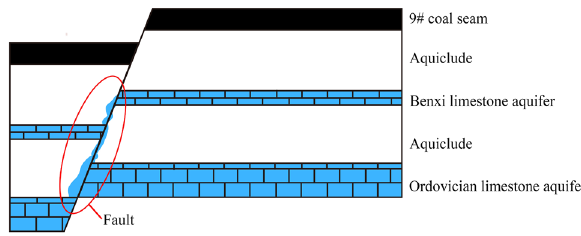
Figure 2. The relative position of the strata.